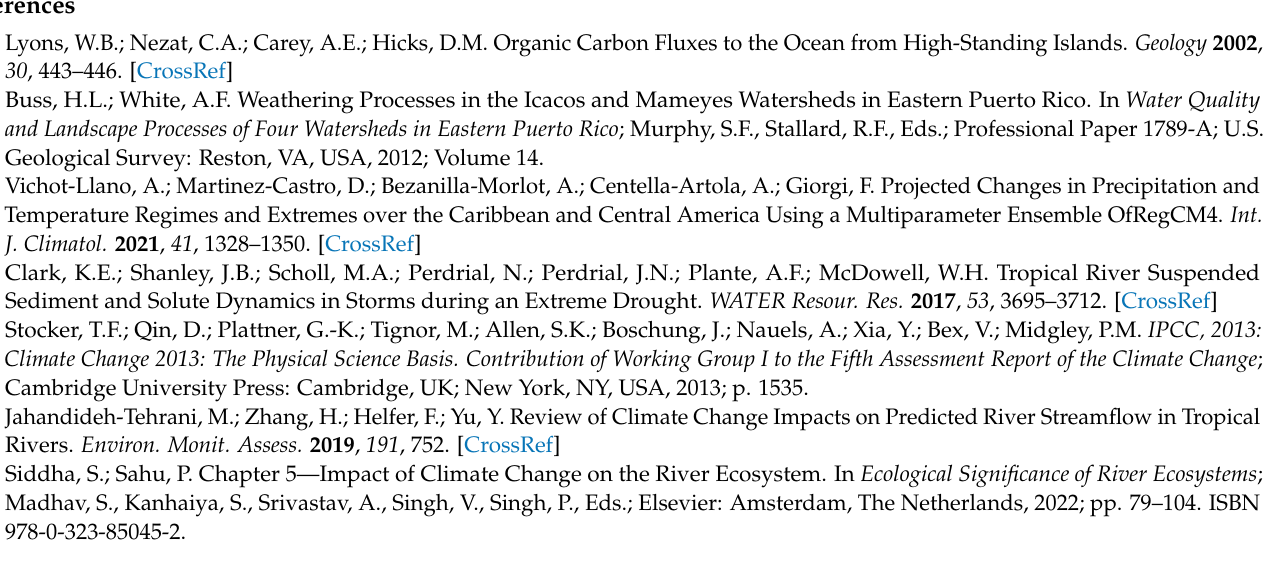
Mameyes. Table S1b: List of analyzed samples from Rio Icacos. Table S1c: List of analyzed